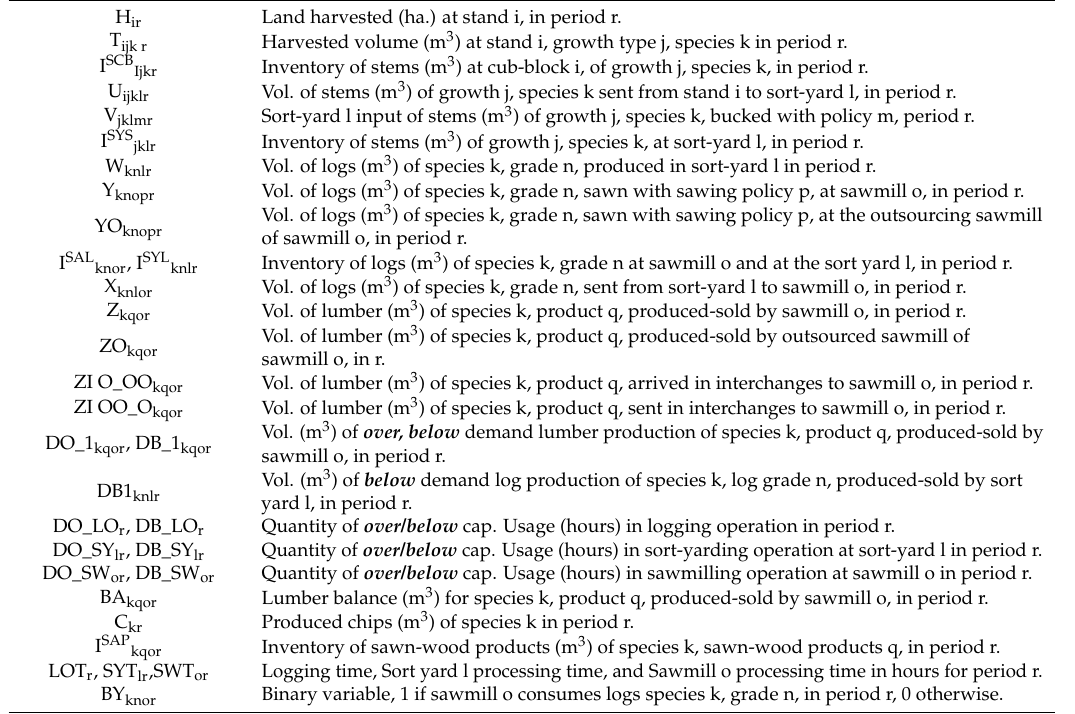
Table A5. Decision variables.